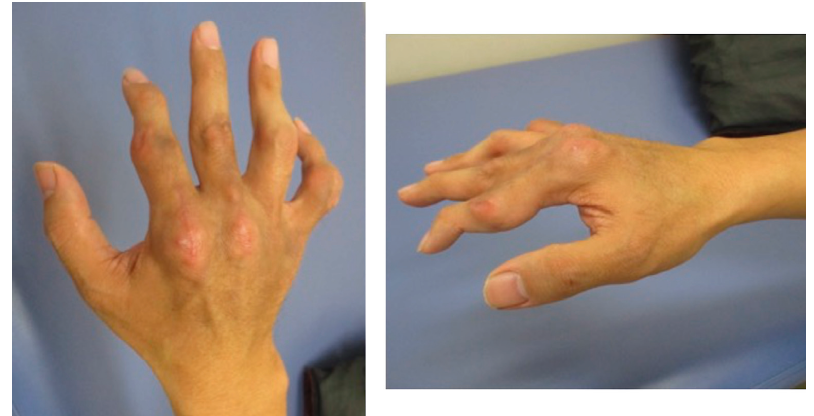
Figure 5: Photograph of the right hand 6 weeks following surgery showing significant reduction of the